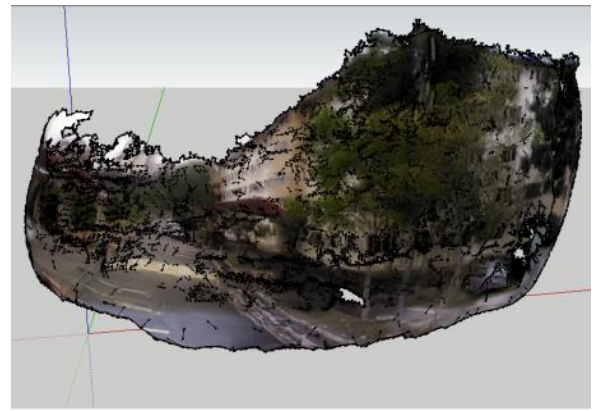
Figure 3. Low quality 3D model before editing, extracted from AgiSoft PhotoScan in 3DS format and imported to SketchUp Trimble.